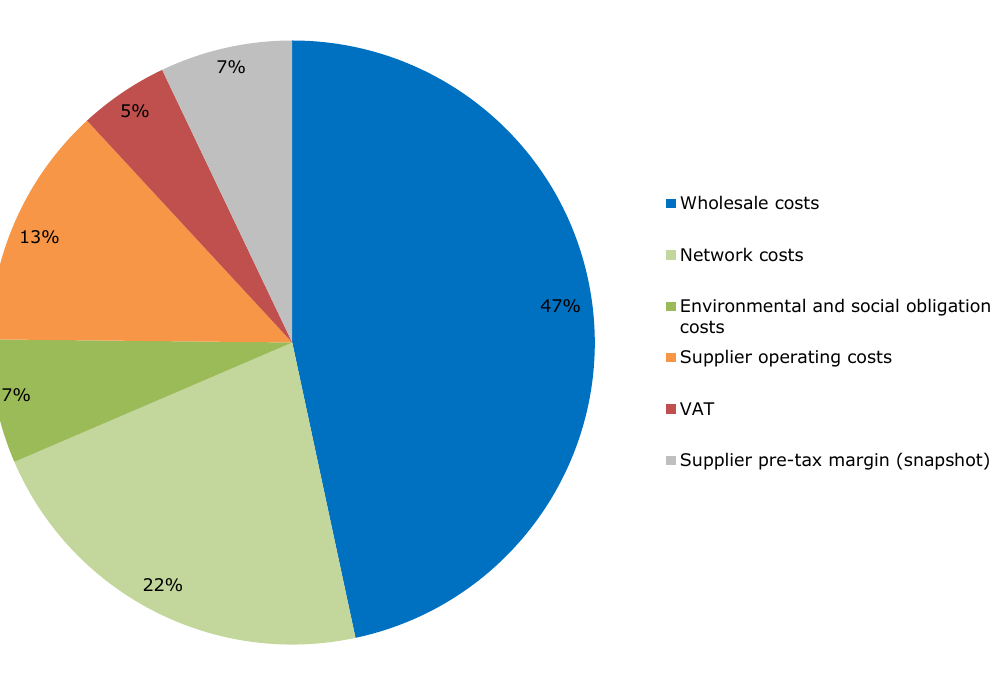
Figure 5: The average annual dual fuel bill: breakdown of